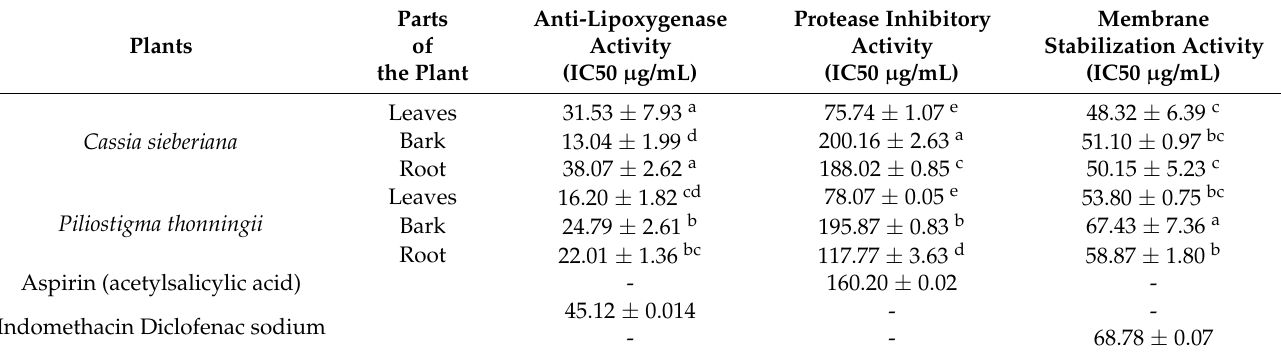
Table 3. In vitro anti-inflammatory activity of aqueous extracts of C. sieberiana and P. thonningii .